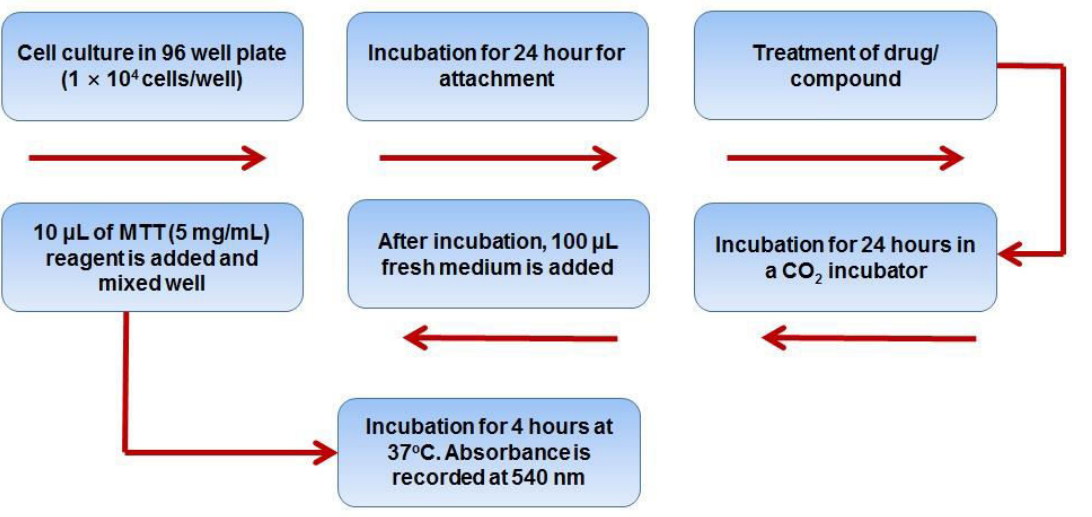
Figure 2: Schematic representation of MTT assay protocol